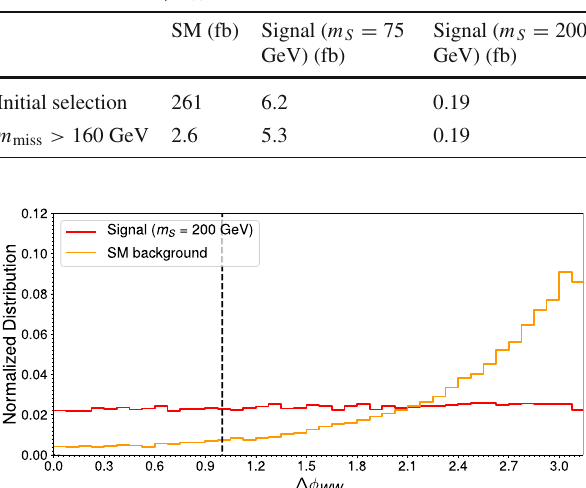
√ s | ee = 3 TeV events. Normalized (cid:13)φ WW distribu- Fig. 6 L nc γγ ( y ) , tion for the SM background (orange) and m S = 200 GeV signal (red). The selection cut (cid:13)φ WW < 1 is also shown (dashed-black line)